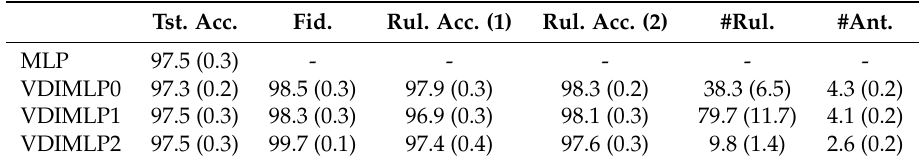
Table 1. Average results on the thyroid dataset. From left to right: predictive accuracy, fidelity, predictive accuracy of the rules, predictive accuracy of the rules when rules and network agree, number of rules, number of antecedents. Numbers in brackets designate standard deviations.